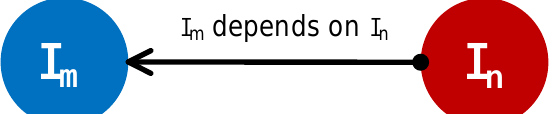
Figure 3 . Dependency relation between two interactions. (Zeng,